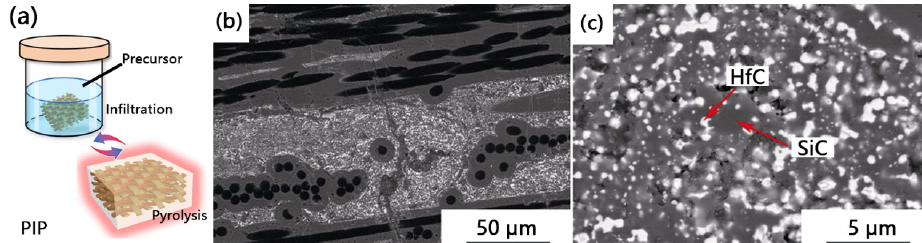
Fig. 16 Schematic diagram of PIP (a); microstructure of PIP–C f /HfC–SiC composites (b, c). Reproduced with permission from Ref. [232], © The Author(s)